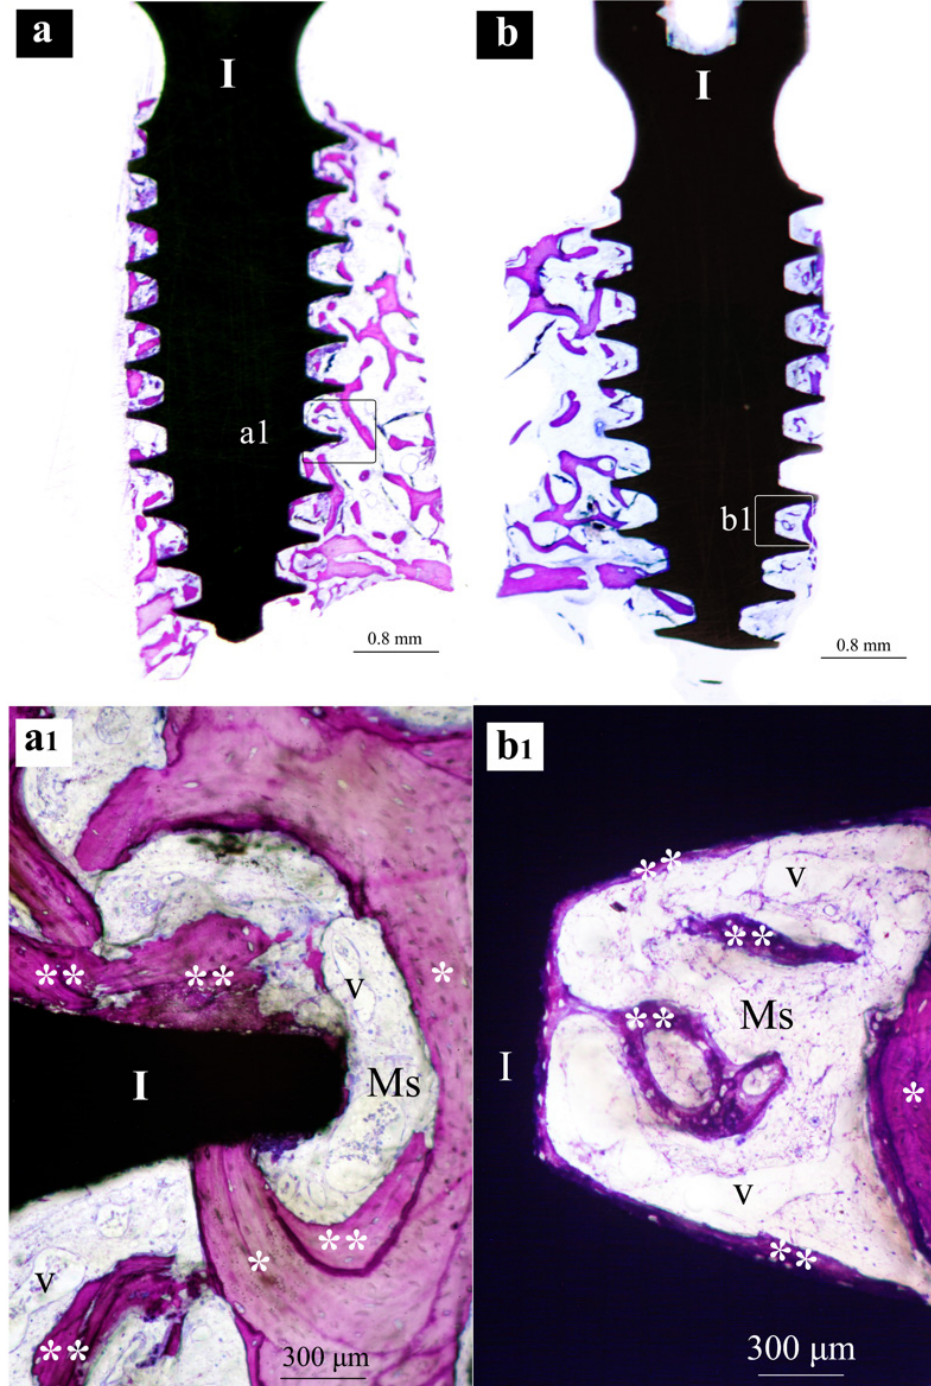
Figure 5. Central sections of two implants of the XPEED group after 4 weeks of healing. In ( a , b ), original magnifications ( × 12), the implant bodies (I), along the entire threaded regions, appear to be surrounded by mineralized bone. In ( a1 ), original magnifications ( × 200), the implant threads (I) appear to be in contact with both newly formed bone (**) and native bone trabeculae (*), while in the marrow spaces (Ms) enlarged vessels (v) are present near the implant surface, In ( b1 ), original magnifications ( × 200), the implants (I) in the inter-thread space, a thin layer of newly formed bone (**) appear to be in contact with the implant surface forming struts of bone toward area of native bone (*). In the marrow spaces (Ms) several enlarged vessels (v) are visible.